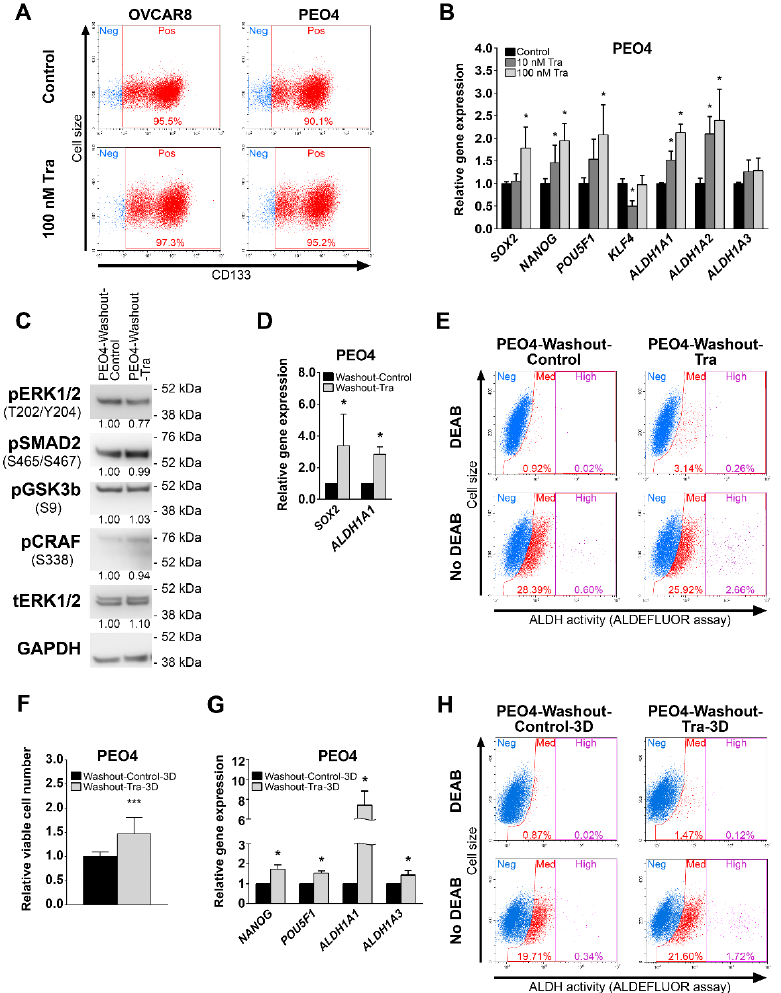
Figure 5. Effects of trametinib treatment on stemness-related characteristics of HGSOC cells. ( A ) Expression of the CD133 surface marker in cells treated with trametinib for 72 h. Gates indicate CD133-negative (“Neg”) and CD133-positive (“Pos”) cell subpopulations. ( B ) Gene expression levels of stemness-related genes in cells treated with trametinib for 10 h. Data are normalized to “Control” samples and presented as mean + S.D. ( n = 3, two-tailed Student’s T-test with Welch’s correction, * - p < 0.05). ( C ) Immunoblotting analysis of various signaling proteins activation in PEO4-Washout cells. Numbers under the bands represent relative intensity normalized to GAPDH levels and PEO4-Washout-Control sample. ( D ) Gene expression levels of stemness-related genes in PEO4-Washout cells. Data are normalized to “Washout-Control” samples and presented as mean + S.D. ( n = 3, two-tailed Student’s T-test with Welch’s correction, * - p < 0.05). ( E ) ALDEFLUOR analysis of PEO4-Washout cells. N , N -diethylaminobenzaldehyde (DEAB) was used as ALDH inhibitor to define background ALDEFLUOR signal and set proper gates for ALDH-positive cells. Gates indicate cell subpopulations displaying negative (“Neg”), medium (“Med”), or high (“High”) levels of ALDH activity. ( F ) Viable cell numbers of PEO4-Washout cells after cultivation in non-adherent 3D conditions for 7 days. Data are normalized to “Washout-Control-3D” samples and presented as mean + S.D. ( n = 9, Mann-Whitney U-test, *** - p < 0.001). ( G ) Gene expression levels of stemness-related genes in PEO4-Washout cells after cultivation in non-adherent 3D conditions for 7 days. Data are normalized to “Washout-Control-3D” samples and presented as mean + S.D. ( n = 3, two-tailed Student’s T-test with Welch’s correction, * - p < 0.05). ( H ) ALDEFLUOR analysis of PEO4-Washout cells after cultivation in non-adherent 3D conditions for 7 days. DEAB was used as ALDH inhibitor to define background ALDEFLUOR signal and set proper gates for ALDH-positive cells. Gates indicate cell subpopulations displaying negative (“Neg”), medium (“Med”), or high (“High”) levels of ALDH activity.